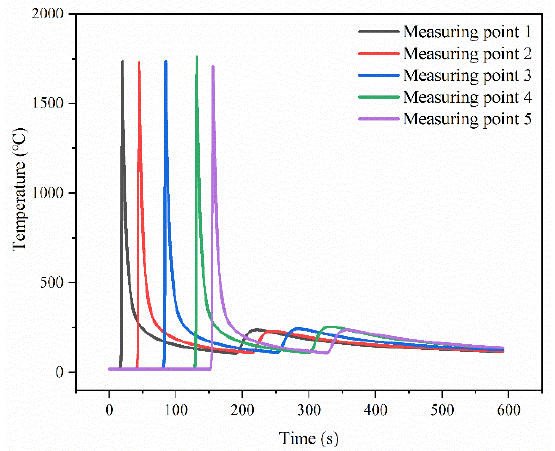
Figure 13. Temperature history curve of path 1.